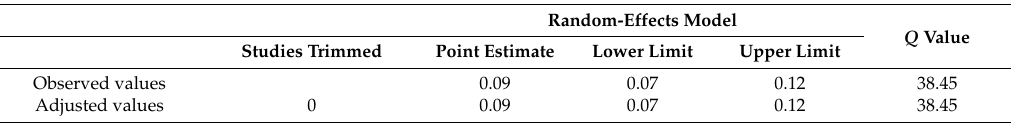
Table 7. Duval and Tweedie’s trim-and-fill analysis for “everyday drinking” consumption rate among truck drivers.